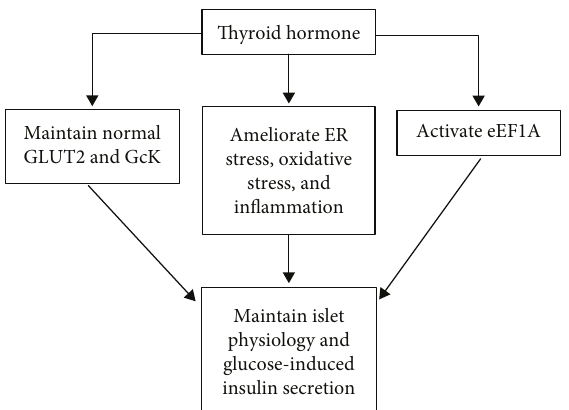
Figure 2: The e ff ect of thyroid hormones on normal pancreatic physiology. ER: endoplasmic reticulum; eEF1A: eukaryotic elongation factor 1A; GcK: glucokinase; GLUT2: glucose transporter